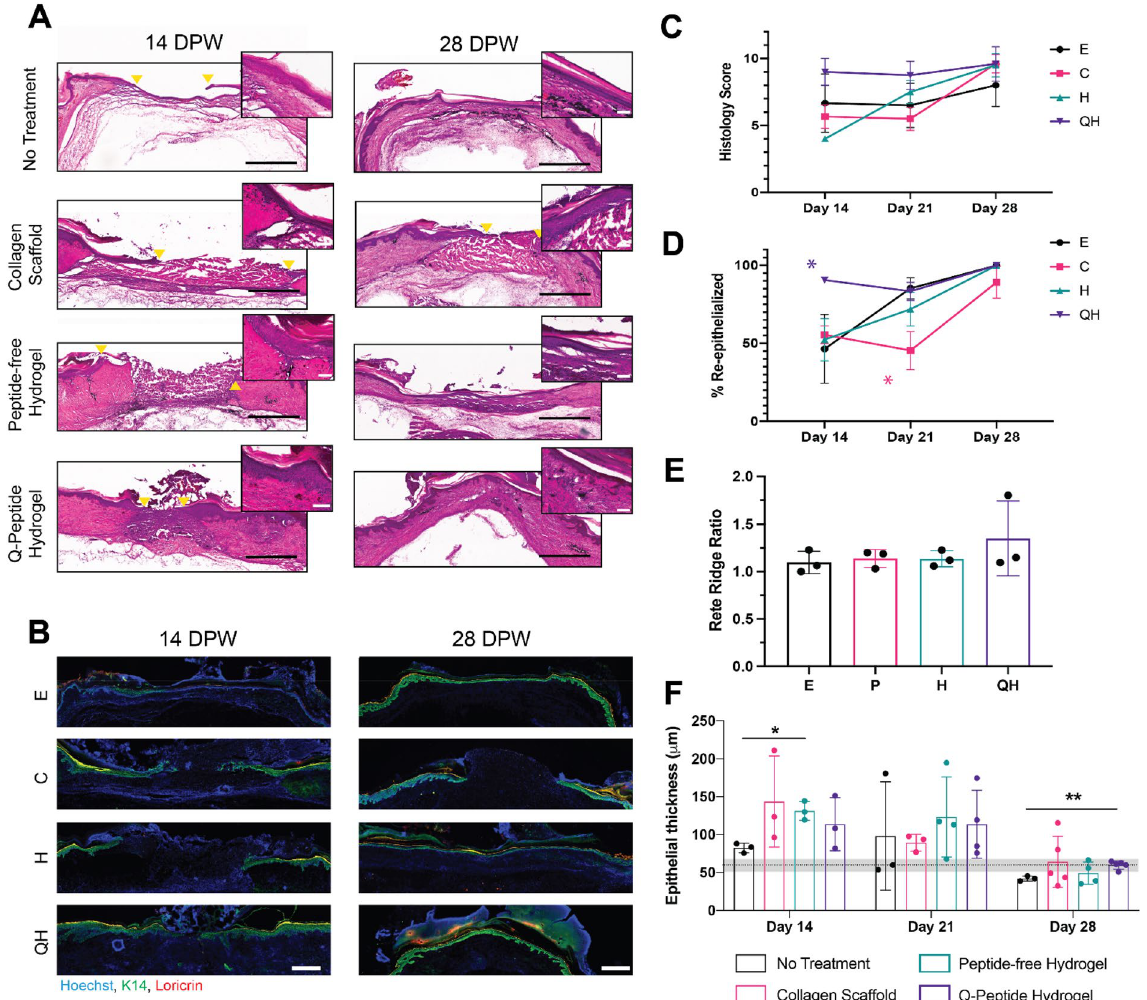
Figure 4. Histology of healing wounds reveals accelerated wound re-epithelialization with Q-Peptide Hydrogel treatment. ( A ) Representative Hemotoxylin and Eosin stained cryosections from the middle of wounds at 14, and 28 days post wounding (DPW). Yellow arrow heads indicate measurements used for wound gap. SB = 1 mm. Inset SB = 0.1 mm. ( B ) Immunostained tissue sections on day 14 and day 28 for K14 (Green), Loricin (Red) and Hoechst (Blue). SB = 500 μm. ( C ) Qualitative histology scoring (1–12, with higher scores indicating greater granulation tissue filling, re-epithelialization, and reduction of cellular infiltration) shows a trend ( p = 0.09) toward faster and more complete wound healing following treatment with Q-Peptide Hydrogel. ( D ) Significantly faster re-epithelialization of wounds treated with Q-Peptide Hydrogel was observed at earlier timepoints (days 14 and 21, p < 0.05). ( E ) Measured rete ridge ratio at D28 for no treatment, collagen scaffold, Peptide- free hydrogel, and Q-Peptide Hydrogel. ( F ) Measurement of epithelial thickness in healing wounds revealed thickening of neoepidermis in all groups at early timepoints (day 14 and 21) compared with uninjured human skin (dashed line +/− SD, area shaded in grey). Treatment with Q-Peptide Hydrogel promoted more complete return to pre-injury epidermal thickness by day 28 compared with no treatment control. * p < 0.05, * p < 0.05 (collagen scaffold significantly less than other treatments) ** p < 0.005, E = No treatment, C = collagen scaffold, H = Peptide-free hydrogel, QH = Q-Peptide Hydrogel, N =